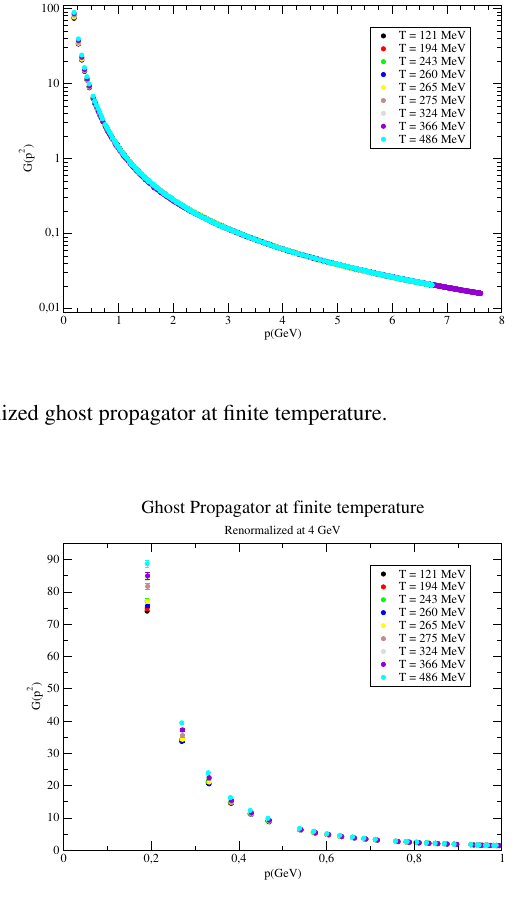
Figure 2. Renormalized ghost propagator at finite temperature in the IR